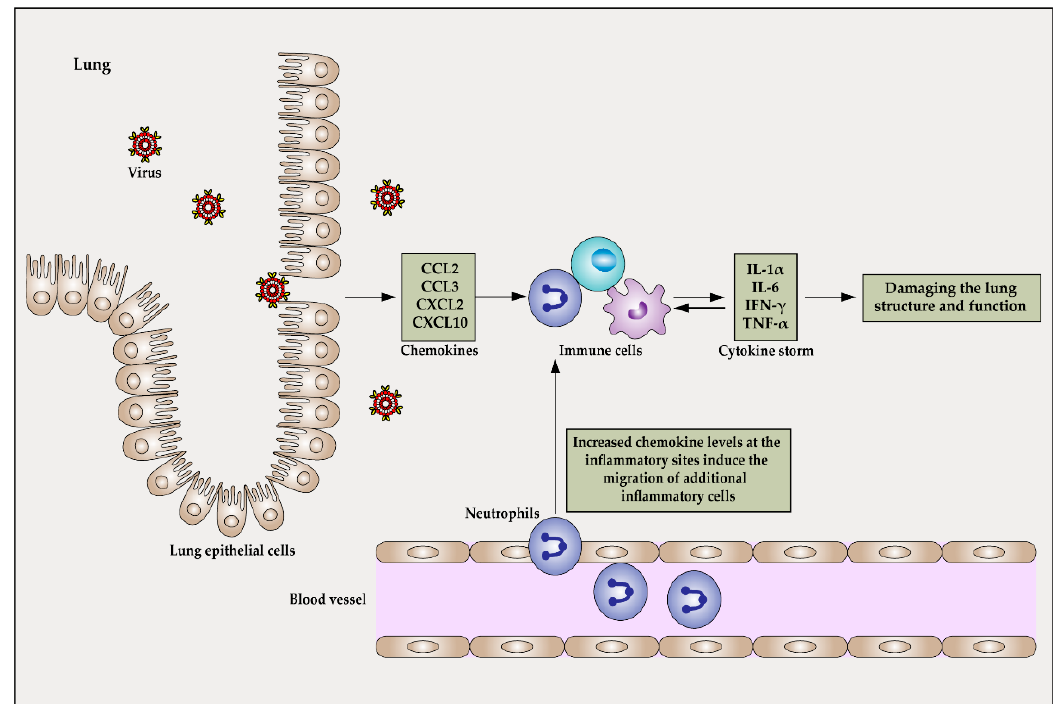
Figure 2. Cytokine storm in the lung after influenza virus infection. Influenza virus is mainly transmitted through the respiratory tract, such as the trachea, into the alveoli. Once inside the body, the virus can also be transmitted through blood circulation. When the influenza virus infects lung epithelial cells and alveolar macrophages, it replicates, causing a release of a large number of viruses that induce the release of host cytokines. Activation of macrophages by cytokines and chemokines leads to additional immune responses that can trigger a cytokine storm. At the same time, increased chemokine levels at the inflammatory site induce migration of additional cytokine-releasing inflammatory cells to the site, thus amplifying the cytokine storm effect.